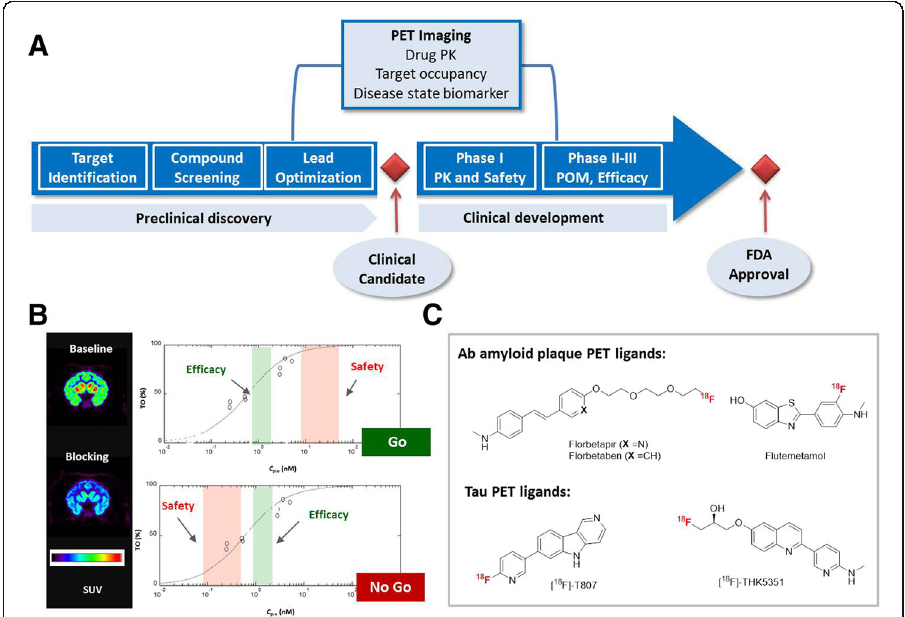
Fig. 1 Applications of PET imaging in the CNS drug discovery